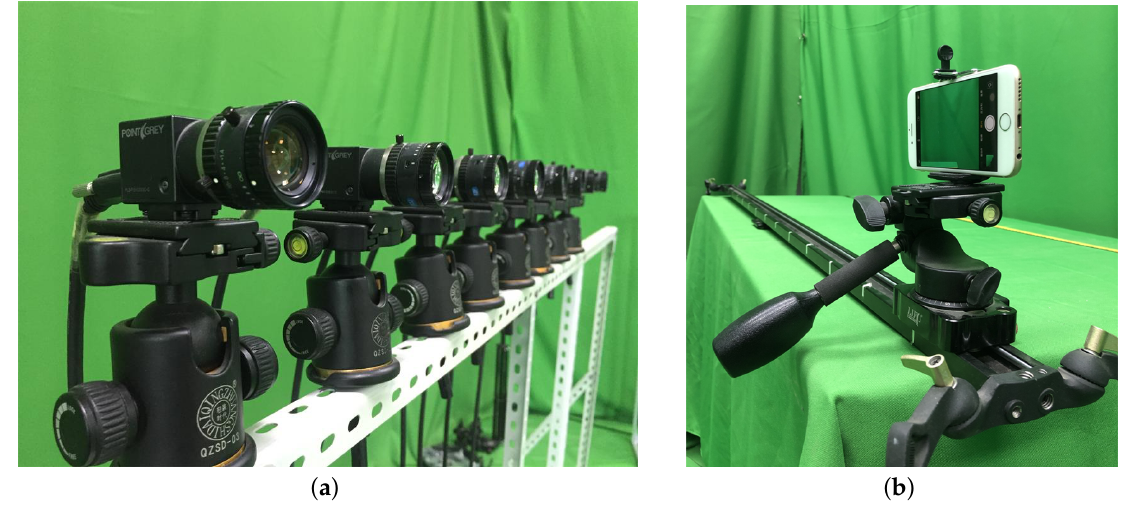
Figure 3. ( a ) Camera array. ( b ) Camera slide